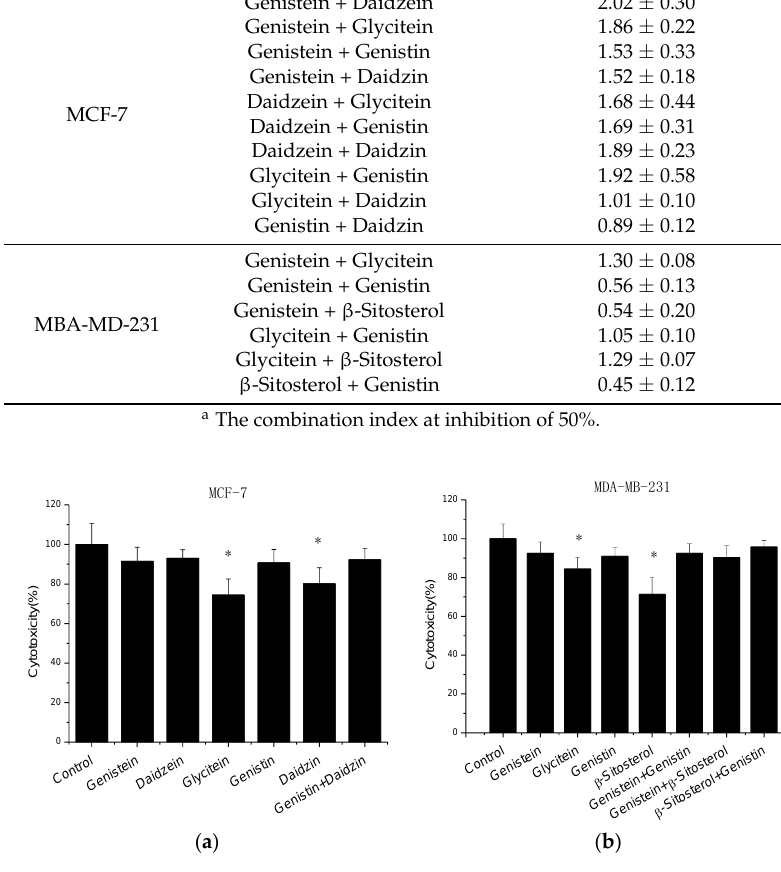
Figure 3. Cytotoxicity of bioactive anticarcinogens by alone or two-way combination treatment in MCF-7 ( a ) and MDA-MB-231 ( b ) human cancer cells. Data are presented as mean ± SD. * Indicates a significant difference compared to the control ( p < 0.05).